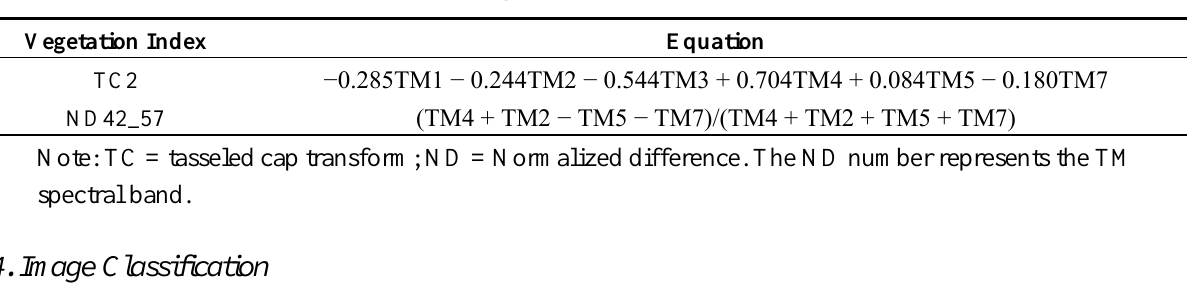
Table 2. Vegetation indices explained.